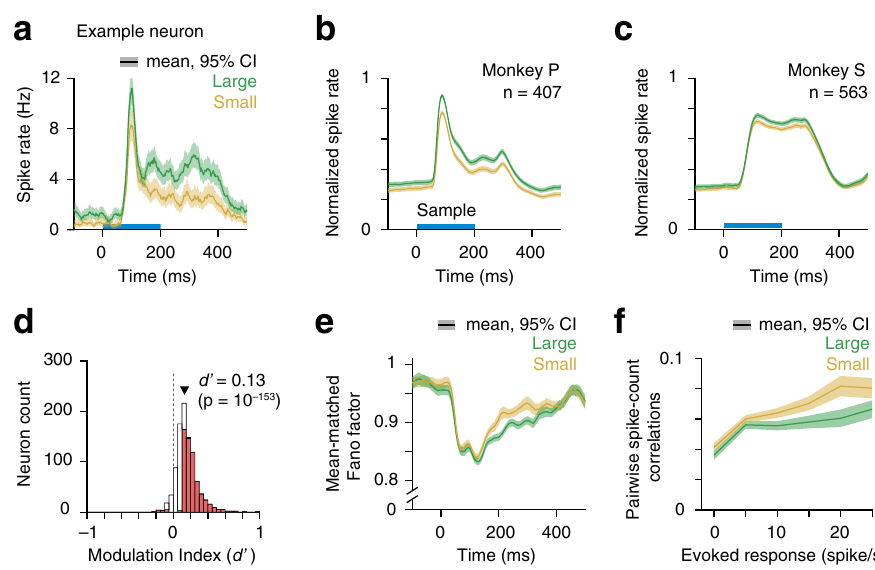
Fig. 3 Higher attentional intensity increased spiking of neurons in area V4. a Peri-stimulus time histograms (PSTH) of spike rates of correct trials in large- and small-reward blocks for an example neuron in V4. Single-trial spike counts were binned at 2 ms, smoothed with σ = 15 ms half Gaussian and then aligned at the onset of sample stimulus. Horizontal bar, sample stimulus presentation. Population PSTHs for monkey P ( b ) and monkey S ( c ). For population average, spike rates of each neuron were normalized to its peak response within 60 – 260 ms from sample stimulus onset (monkey P, n = 407; monkey S, n = 563). Error bars, 95% con fi dence intervals (bootstrap, n = 10 4 ). d Distribution of neuronal modulation indices (MI) of all units from both monkey P and S ( n = 970). MI was measured by neuronal d ′ (see “ Methods ” ). Red bars, neurons with MI values signi fi cantly different from 0 ( n = 595/ 970, p < 0.05; two-sided t -test). White bars, nonsigni fi cant MI. Solid triangle, population MI averaged across all units ( n = 970, p = 10 − 153 , two-sided t -test). e Mean-matched Fano factor. Error bars, 95% con fi dence intervals. f Pairwise correlations between spike counts of simultaneously recorded neurons over 60 – 260 ms from sample onset ( n = 20,005 pairs, all units) and binned according to their evoked responses (geometric mean). Error bars, 95% con fi dence intervals.